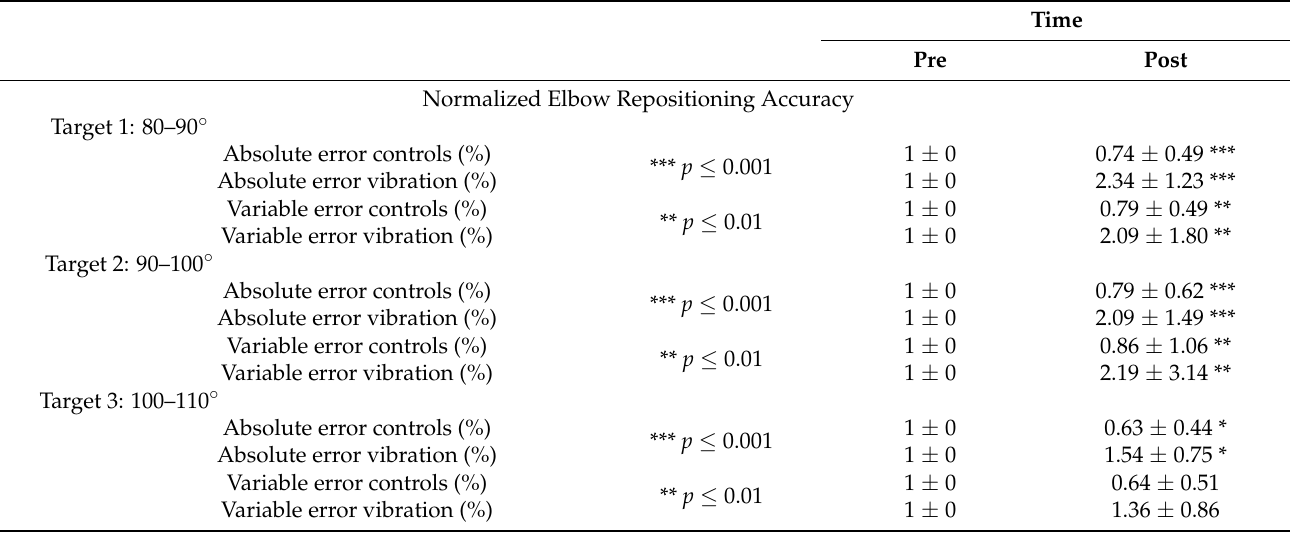
Table 2. Normalized and absolute elbow proprioception accuracy data for both groups.